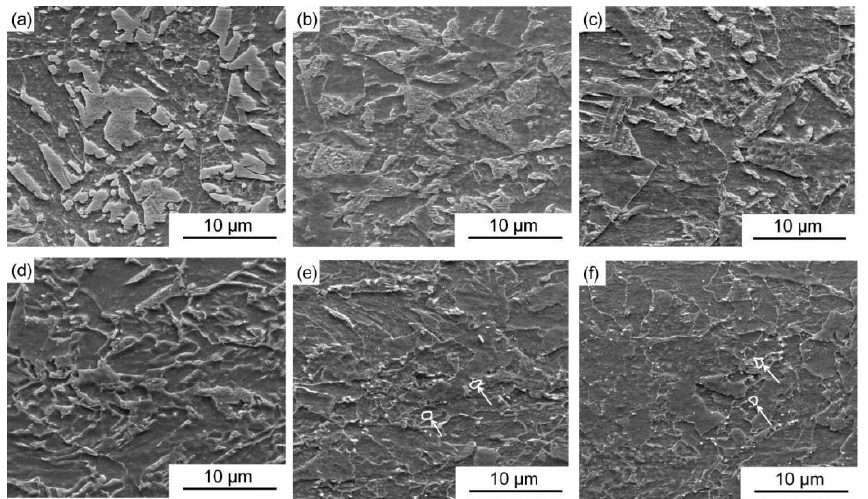
Figure 4. The SEM microstructures’ morphology of experimental steel at different temperatures: ( a ) the as-rolled state; ( b ) holding at 300 °C for 15 min; ( c ) holding at 400 °C for 15 min; ( d ) holding at 500 °C for 15 min; ( e ) holding at 600 °C for 15 min; ( f ) holding at 700 °C for 15 min.